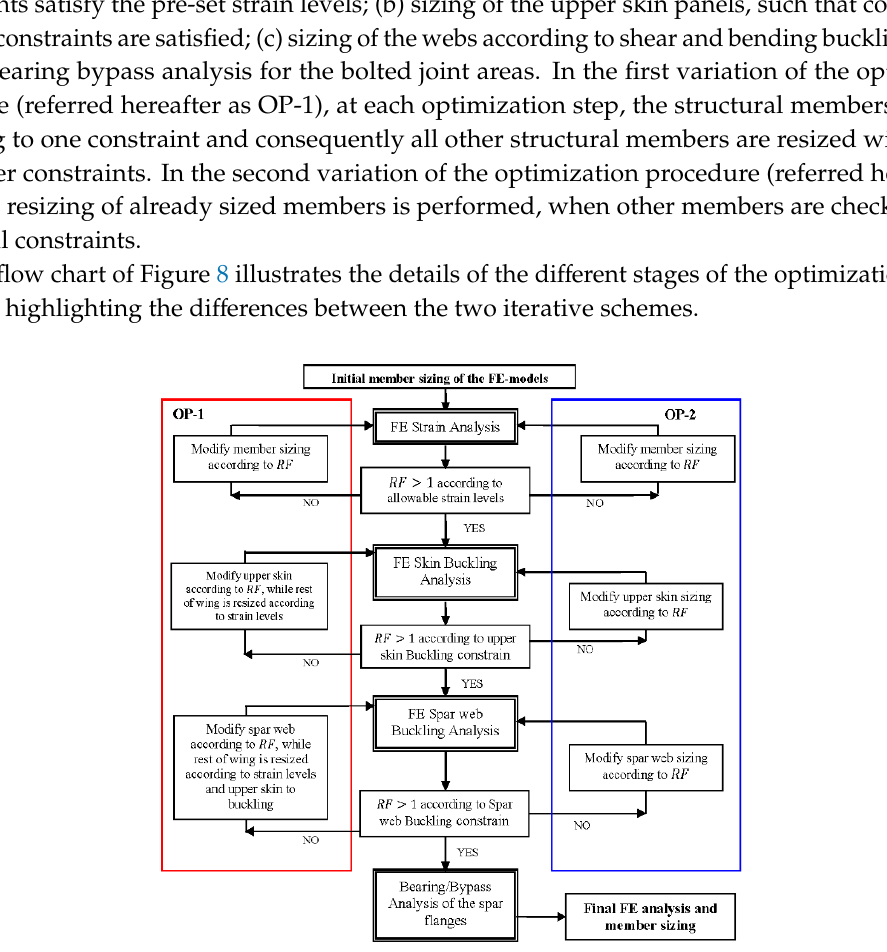
Figure 8. Detailed flow chart of the two variations of the optimization process applied to both composite wing configurations.